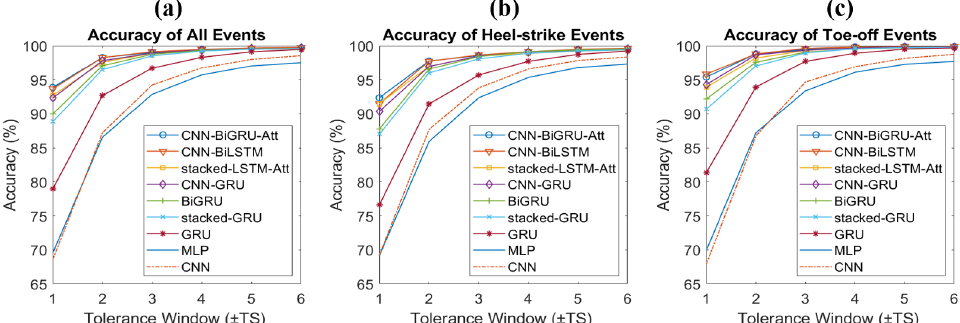
Figure 8. Accuracy plots for key models for ( a ) all events, ( b ) HS events, and ( c ) TO events. To observe the differences in the performance of the events from the right and left foot, the absolute errors in timesteps between the predicted and the groundtruth events were computed. Figure 9 shows the event prediction error of CNN-BiGRU-Att. The mean absolute error (MAE) for all events was 5.77 ms, whereby those for HS and TO events were 6.239 ms and 5.24 ms, respectively. The TO events showed fewer errors than the HS events. No significant difference was found between using the right foot events and the left foot events.